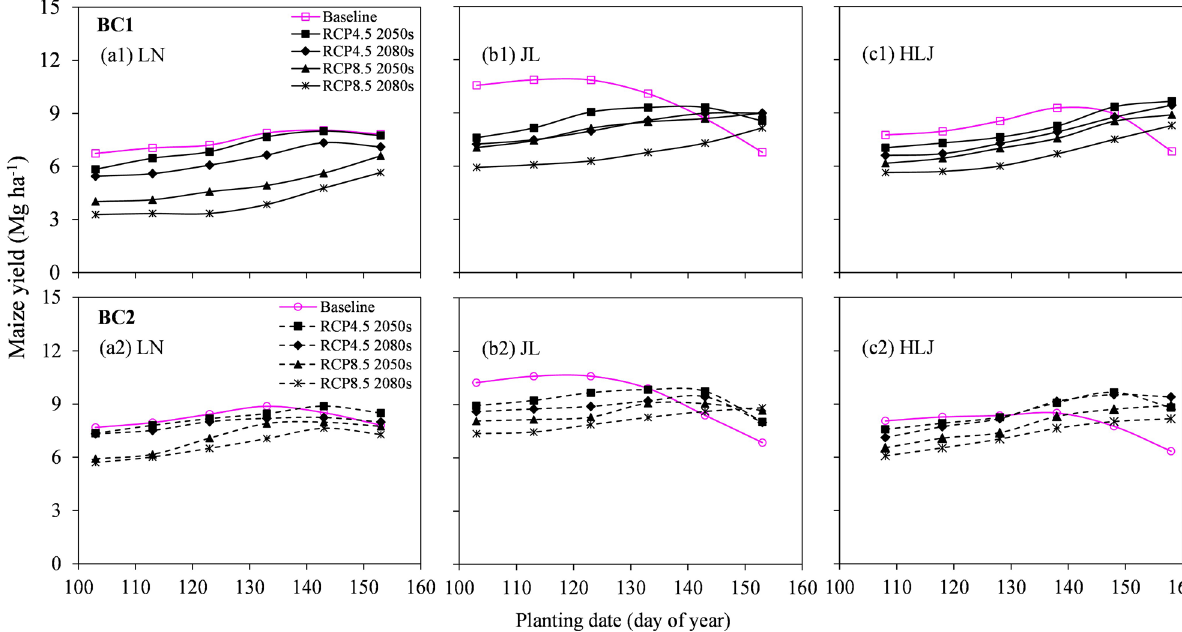
Figure 3. Responses of maize yields to planting date under climate change scenarios BC1 ( a1 , b1 , c1 ) and BC2 ( a2 , b2 , c2 ) at Liaoning (LN), Jilin (JL) and Heilongjiang (HLJ) provinces in Northeast China.